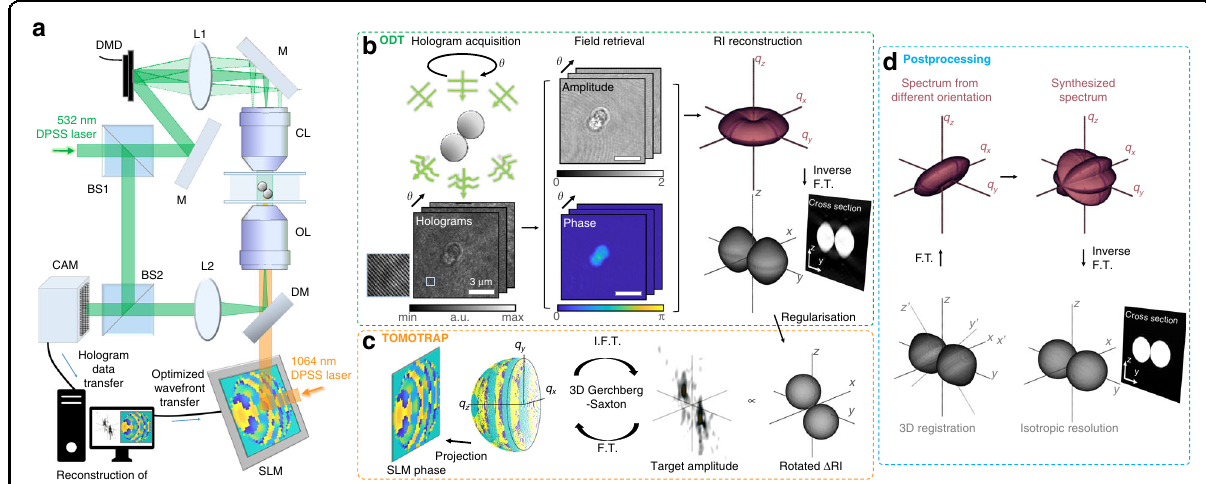
Fig. 1 Experimental setup. a Optical setup (DMD digital micromirror device, L lens, M mirror, CL condenser lens, OL objective lens, DM dichroic mirror, BS beam splitter, CAM camera). b Optical diffraction tomography (ODT). The sample is illuminated at different incident angles, and the corresponding off-axis holograms are recorded. The raw holograms are converted to transmitted fi elds using the fi eld-retrieval algorithm. The obtained fi elds are mapped to the Fourier space, and the inverse Fourier transform reconstructs the refractive index (RI) tomogram with low axial resolution. c Tomographic mould for optical trapping (TOMOTRAP). The phase distribution of the spatial light modulator (SLM) in the Fourier plane was optimised to make the light amplitude maximally overlap the regularised relative sample RI map via a 3D Gerchberg – Saxton (GS) iterative algorithm. d Postprocessing for isotropic 3D reconstruction. A reconstructed tomogram was registered with the initial raw RI tomogram in 3D to estimate the actual 3D orientation. Registration data were applied to obtain a spectrum from a different orientation. Finally, we obtain an isotropically synthesised tomogram and a spectrum devoid of the missing